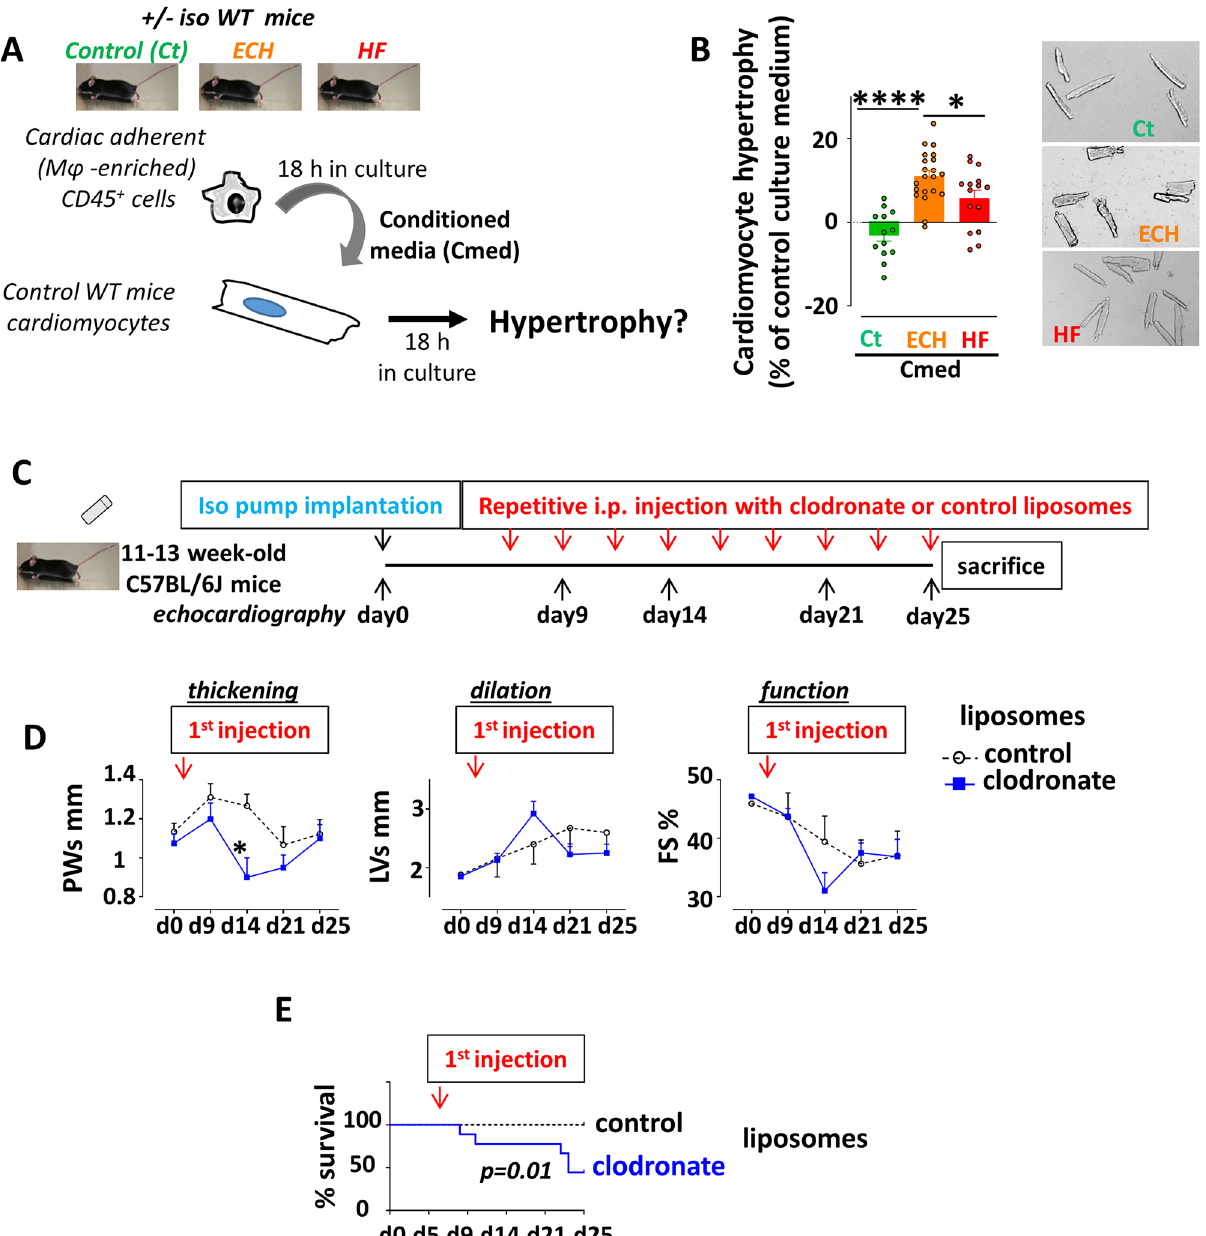
Figure 2. Mφ-enriched adherent CD45 + cells from ECH hearts selectively trigger adult WT cardiomyocyte hypertrophy in-vitro. Mφ depletion during ECH hampers early hypertrophy in-vivo. ( A ) Experimental procedure. Cardiac immune cells were isolated from collagenase digested Ct, ECH and HF hearts. Following CD45 positive enrichment using mouse CD45 microbeads, adherent (Mφ-enriched) cells were kept in culture for 18 h before conditioned media (Cmed) recovery. Cmed were applied on cardiomyocytes from WT mice. Cell hypertrophy was analyzed 18 h later. ( B ) Cmed from adherent CD45 + isolated from iso-infused ECH WT mice selectively enhance hypertrophy of control WT cardiomyocytes. Mean ± SEM of 5 experiments performed in triplicate. Cardiomyocytes from 5 mice (225–750 cell area quantified per condition per experiment), Cmed from 4–10 mice, Kruskal–Wallis followed by Dunn post-hoc test; * p < 0.05, **** p < 0.0001. ( C ) Experimental procedure of clodronate or control liposomes treatment in mice implanted with an iso-pump. ( D ) Echocardiographic parameters measured at d0, d9, d14, d21 and d25; n = 4–9 mice/group, two-way ANOVA followed by Sidak’s post-tests; * p < 0.05 vs control at the same time point. ( E ) Survival of control or clodronate liposomes treated mice; n = 9 mice/group at d0, Gehan-Breslow-Wilcoxon